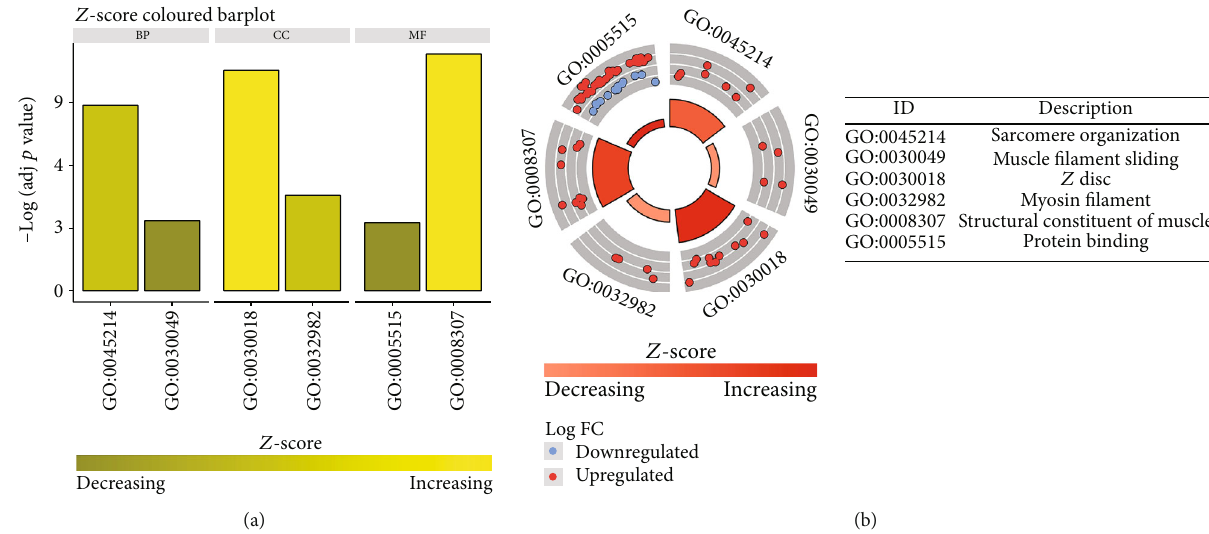
Figure 3: GO term enrichment analysis results. (a) Z-score results for the top 6 GO terms, including the top 2 BPs, CCs, and MFs. (b) Enrichment results for DEGs and the top 6 GO terms. Z-scores were de fi ned as follows: ð upregulated genes – downregulatedgenes Þ /total genes .